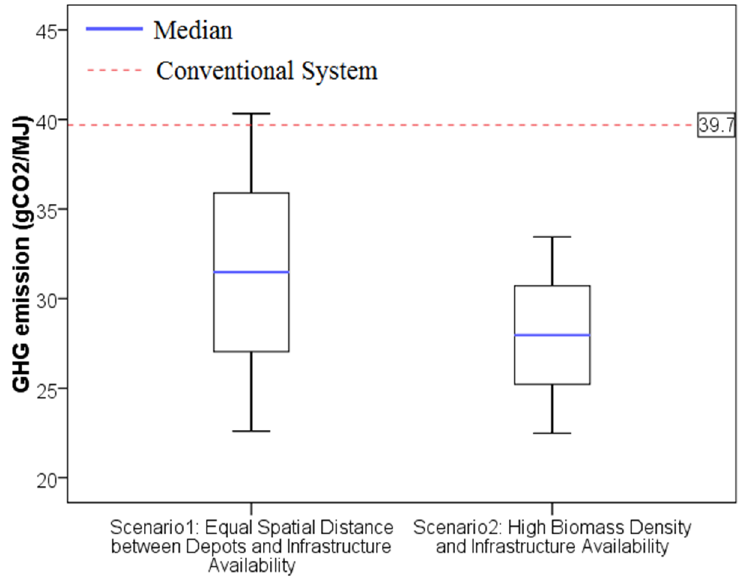
Figure 7. Stochastic life cycle GHG emission results from Monte Carlo simulations for two depot scenarios for the corn stover-to-ethanol logistics and supply chain. The GHG emission for the conventional biorefinery case was obtained from literature [37]. Stochastic estimates based on MC simulation are presented as box and whisker plots. The top of the box represents the 75th percentile, the middle line represents the median (50th percentile) and the bottom of the box represents the 25th percentile. The whiskers correspond to the 5th and 95th